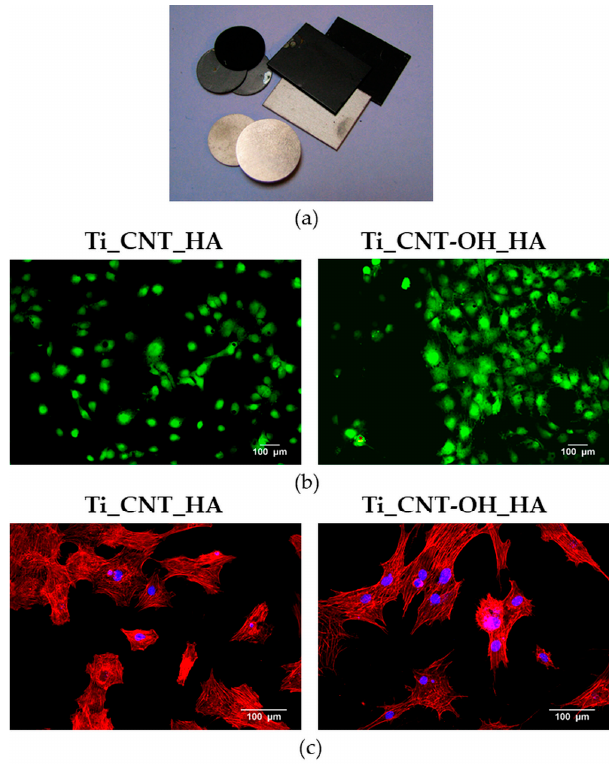
Figure 3. MC3T3-E1 preosteoblasts behavior on the titanium (Ti) samples coated by electrophoretic